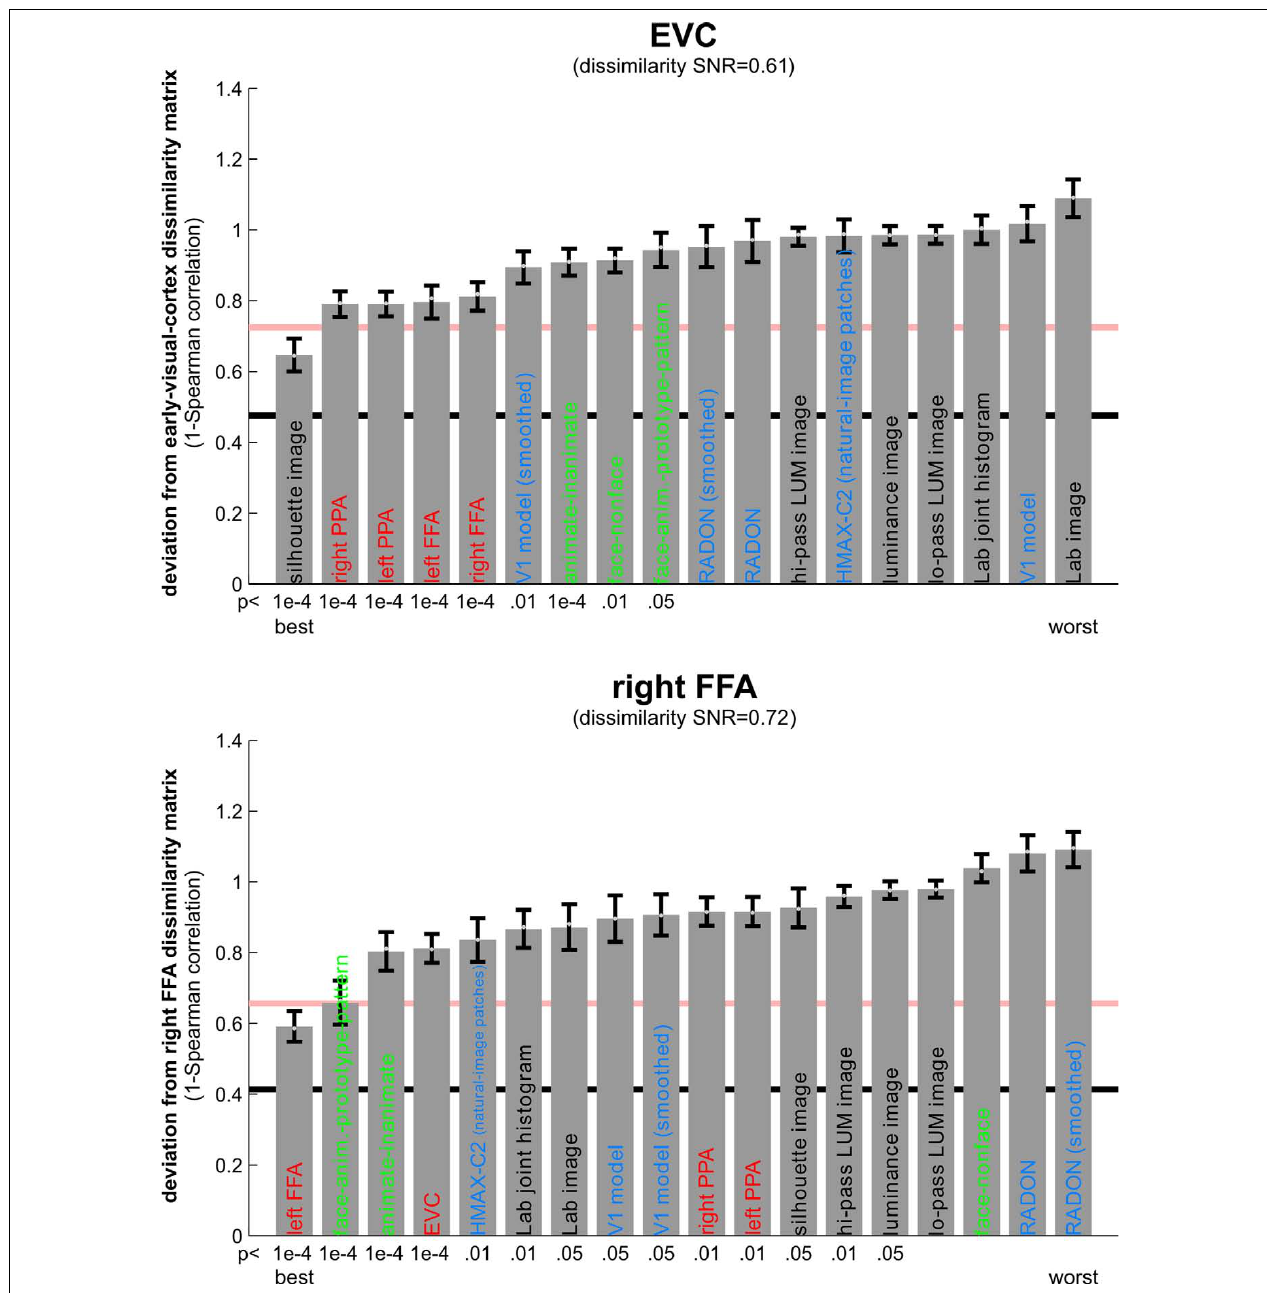
FIGURE 8 | Matching models to brain regions by comparing representational dissimilarity matrices . The dissimilarity matrices characterizing the representation in early visual cortex (top) and the right FFA (bottom) are compared to dissimilarity matrices obtained from model representations and other brain regions. Each bar indicates the deviation between the RDM of the reference region (early visual cortex or the right FFA) and that of a model or other brain region. The deviation is measured as 1 minus the Spearman correlation between dissimilarity matrices (for motivation see Step 4 and Appendix). Text-label colors indicate the type of representation: complex computational model (blue), simple computational model (black), conceptual model (green), brain representation (red). Error bars indicate the standard error of the deviation estimate. (The standard error is estimated as the standard deviation of 100 deviation estimates obtained from bootstrap